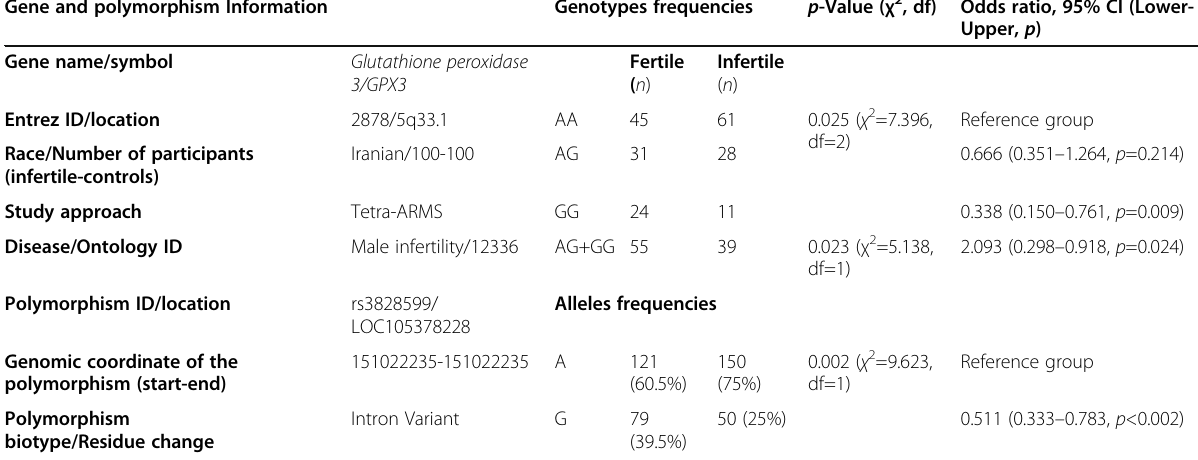
Table 5 The frequency of GPX3 rs3828599 (A to G) genotypes, alleles, and odds ratios in fertile ( n = 100) and infertile ( n = 100) males using χ 2 test and regression logistics analysis